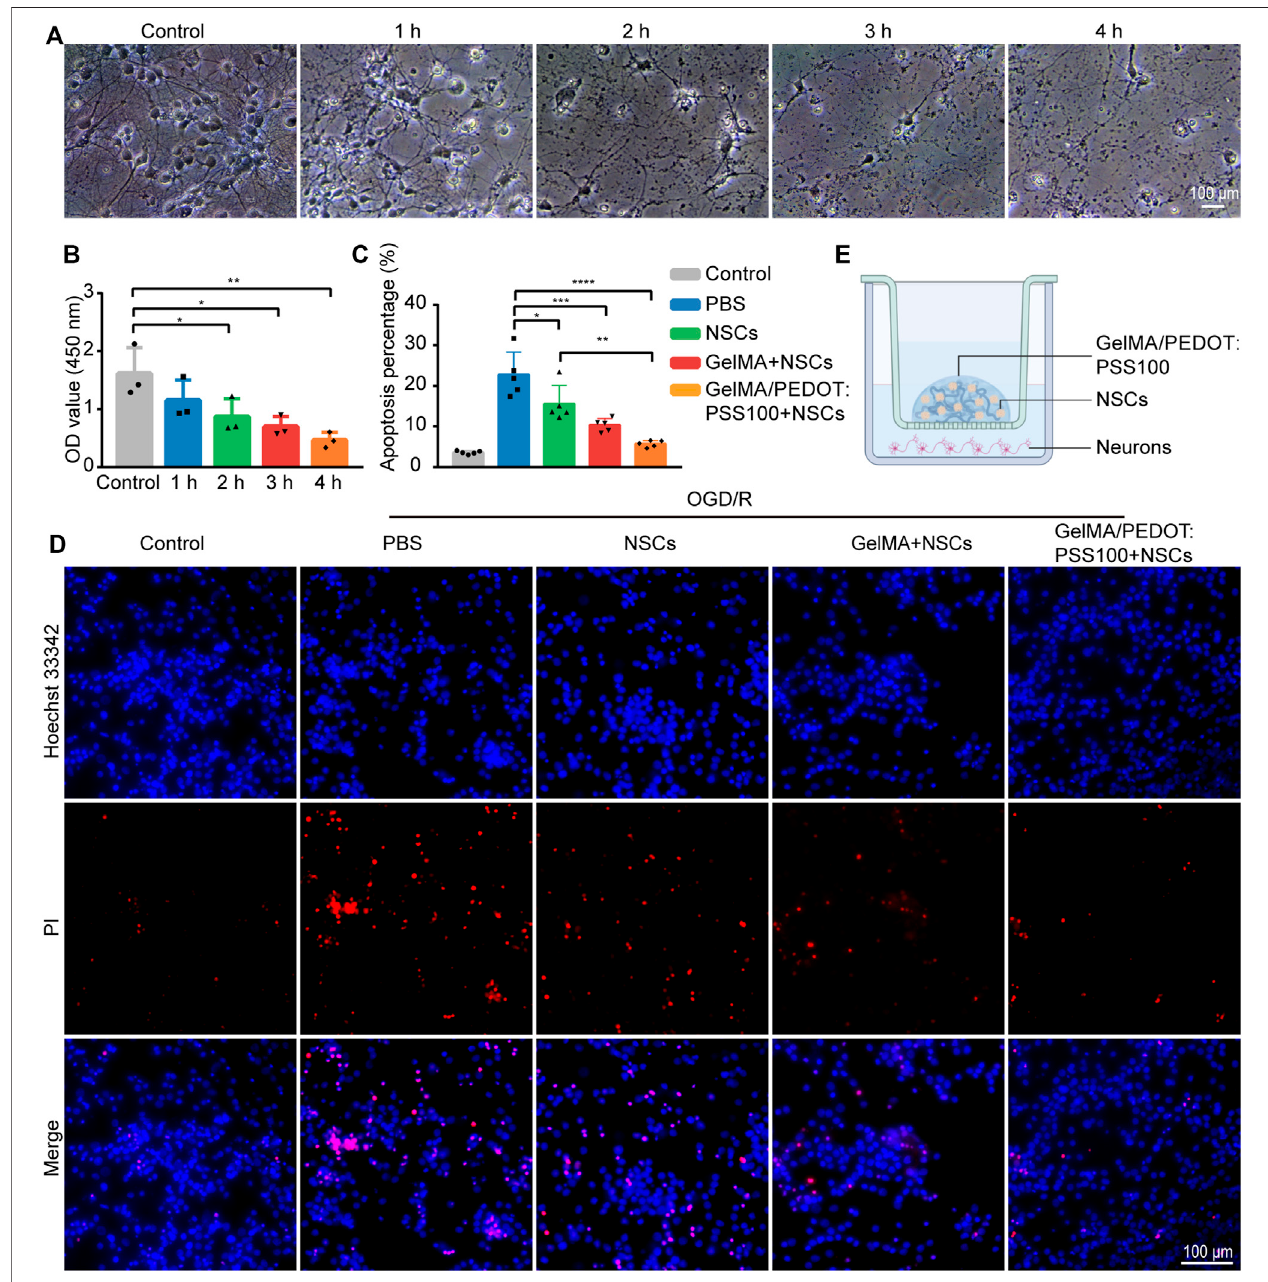
FIGURE 5 | Repairing effects on OGD/R-injured neurons. (A) Neuronal morphology of OGD/R-injured neurons after 1 – 4 h. (B) The cell viability was determined by the CCK-8 assay ofOGD/R-injured neurons. (C) Analysis of the percentage of the apoptotic cells in the different OGD/R treatment groups. (D) Fluorescent microscopic analysis of apoptotic cells stained with PI and Hoechst 33342 in the different OGD/R treatment groups. (E) Diagram of Transwell co-culture system. The data are expressed as mean ± standard deviation. * p < 0.05, ** p < 0.01***, p < 0.001, and **** p < 0.0001.